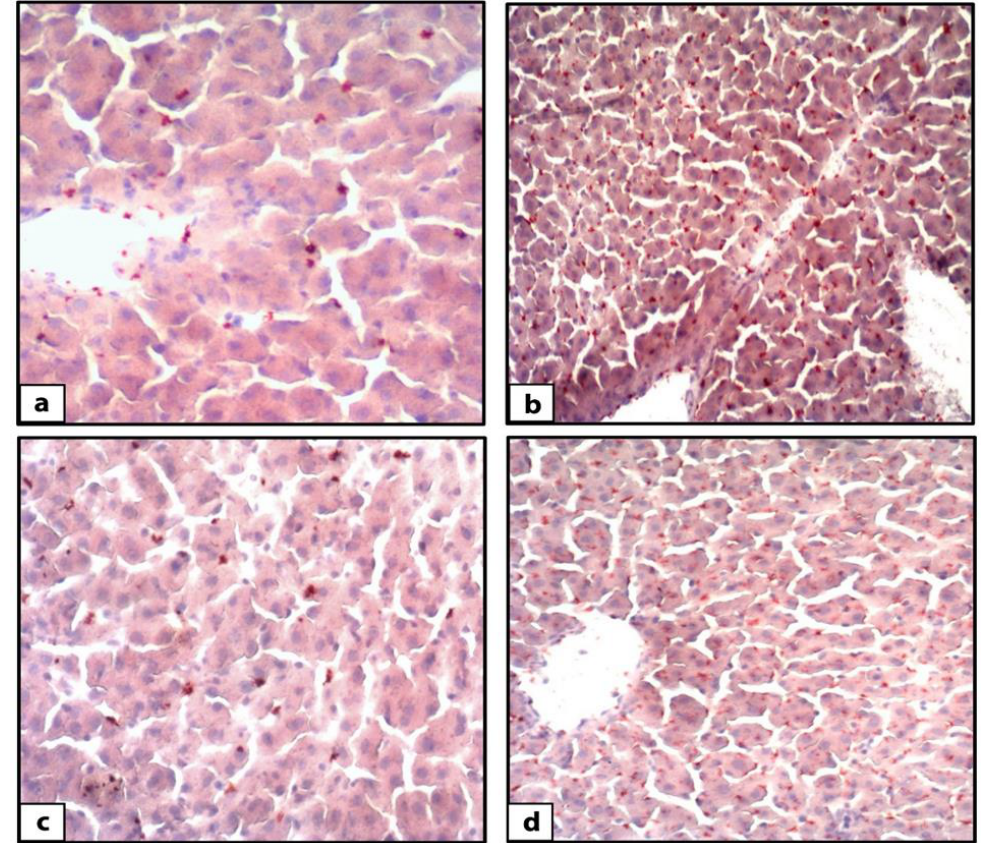
Figure 2. Photomicrographs of Sudan-III-stained rat liver sections. The control group ( a ) showed few lipid droplets (orange colored) accumulations in hepatocytes (Sudan III ×400). DEX-induced MetS group ( b ) showed an accumulation of lipid droplets (orange colored) in hepatocytes (Sudan III ×400). DEX+ LCHF group ( c ) showed few accumulations of lipid droplets (orange colored) in hepatocytes (Sudan III ×400). DEX + HCLF group ( d ) showed an accumulation of lipid droplets (orange colored) in hepatocytes. (Sudan III ×400). DEX: rats treated with dexamethasone to induce metabolic syndrome; DEX + LCHF: rats treated with dexamethasone to induce metabolic syndrome and fed on low-carbohydrate high-fat diet; DEX + HCLF: rats treated with dexamethasone to induce metabolic syndrome and fed on high-carbohydrate low-fat diet.